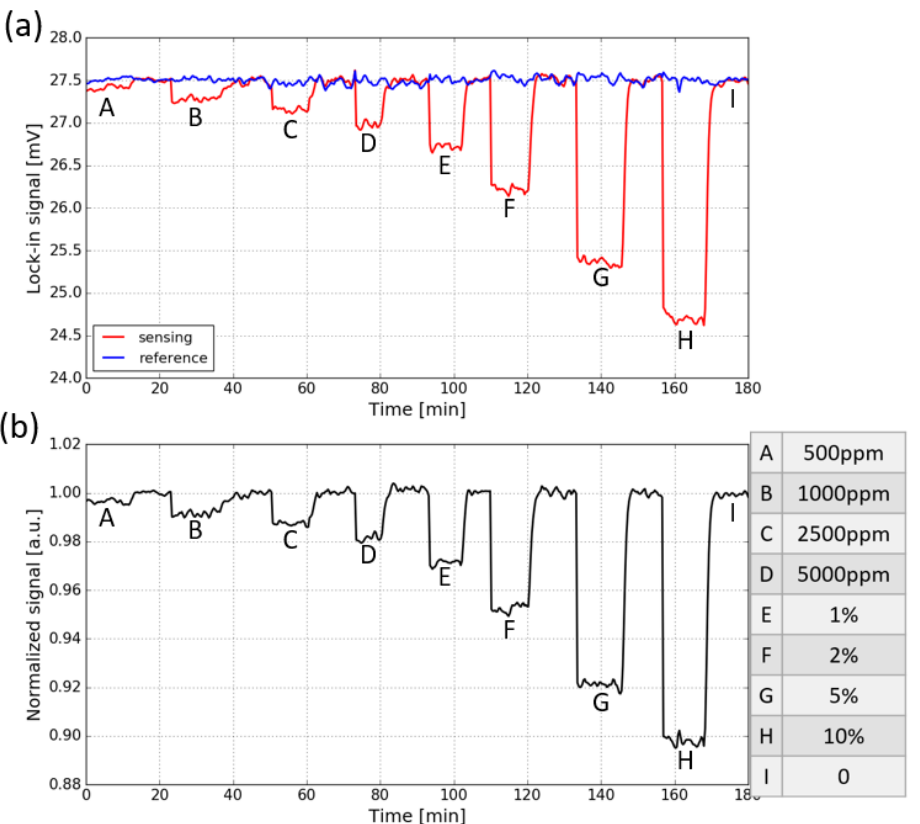
Figure 8. ( a ) Response of both the sensing signal and reference signal to CO 2 concentration steps, the signals are measured with an integration time of 30 s. ( b ) Normalized transmission, obtained by dividing the sensing signal with the reference signal. The CO 2 concentration steps are listed on the right